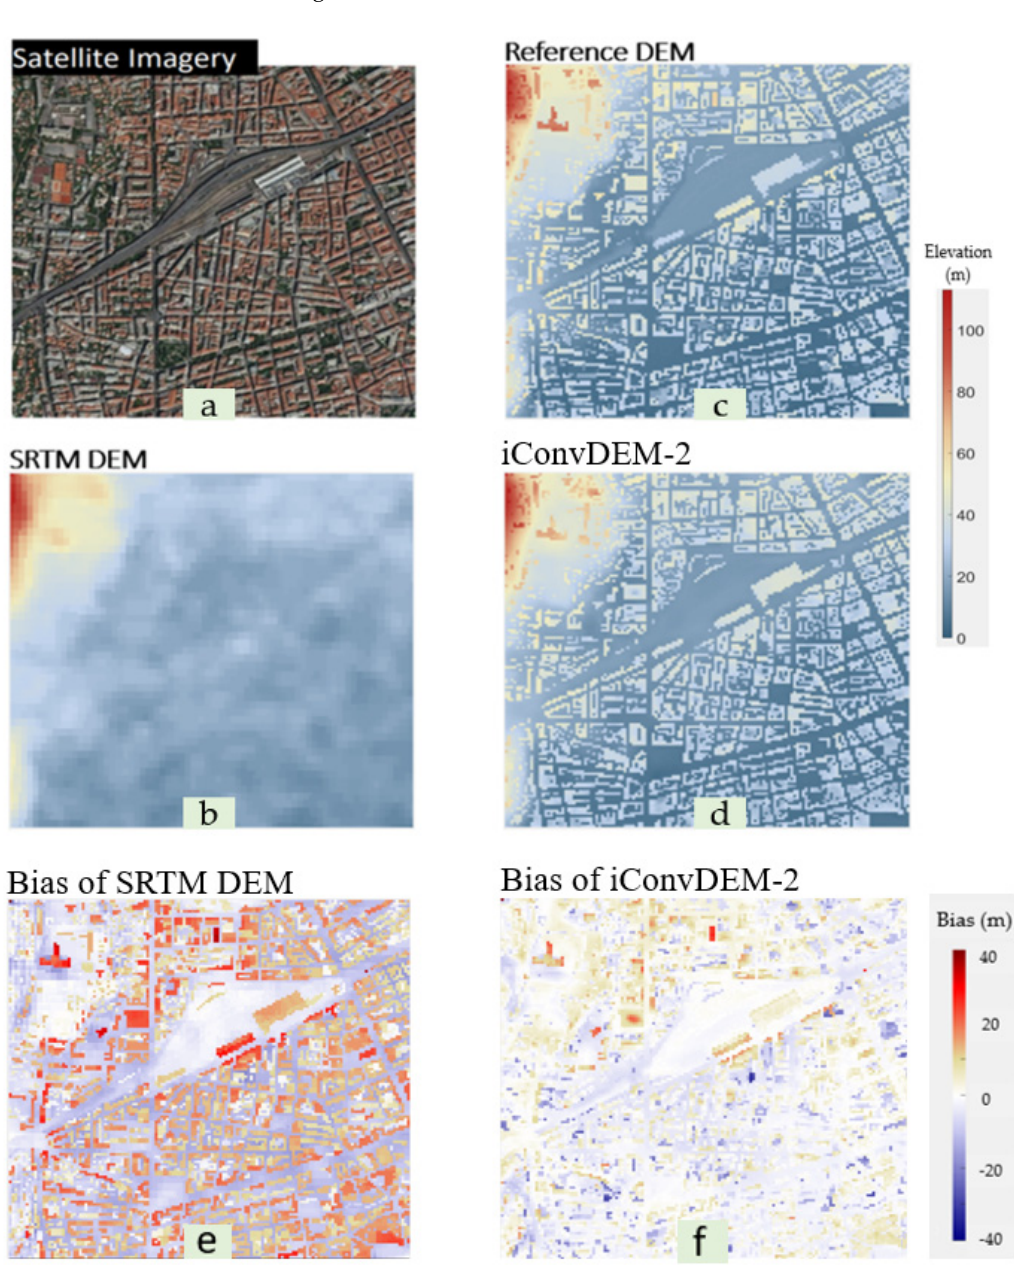
Figure 9. Plots of sub-area within the validation site in Nice from ( a ) Satellite image, ( b ) reference DEM, ( c ) SRTM DEM, ( d ) iConvDEM-2, ( e ) bias of SRTM DEM and ( f ) bias of iConvDEM-2.